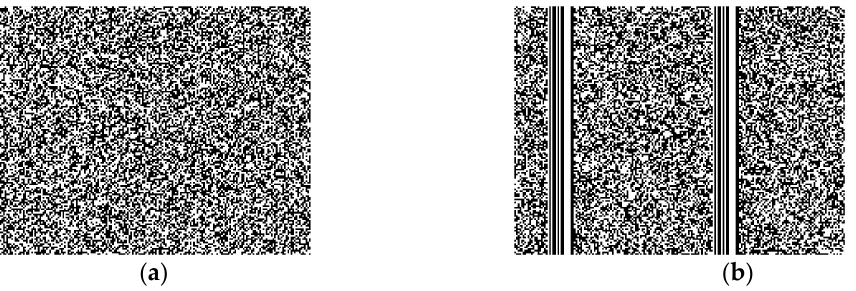
Figure 4. Binary image of interception matrix C . ( a ) l ≠ kL ; ( b ) l = kL .